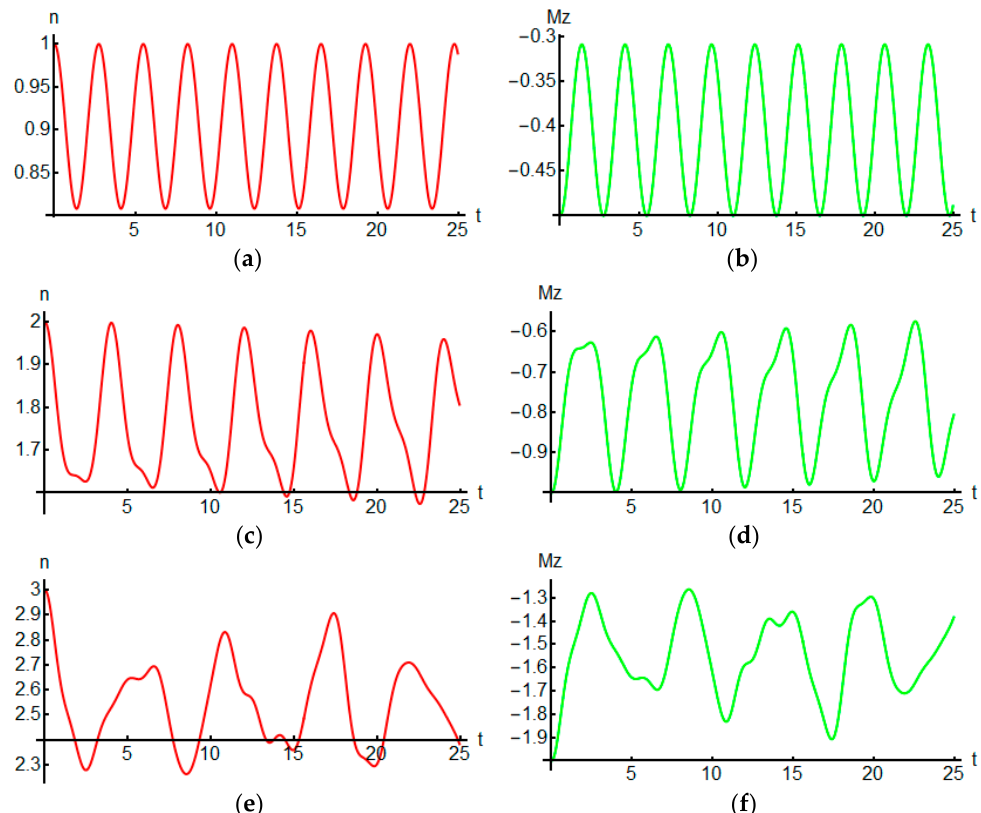
Figure 2. Evolution of magnetic moment amplitude ( a , c ) and the number of photons ( b , d ) for the spin chain interacting with the quantized electromagnetic field. The spin chain consists of 1 spin and the initial state is |1, ↓⟩ in figures ( a , b ), of 2 spins and the initial state is |1, ↓↓⟩ in figures ( c , d ), and 4 spins and the initial state is |3, ↓↓↓↓⟩ ( e , f ).